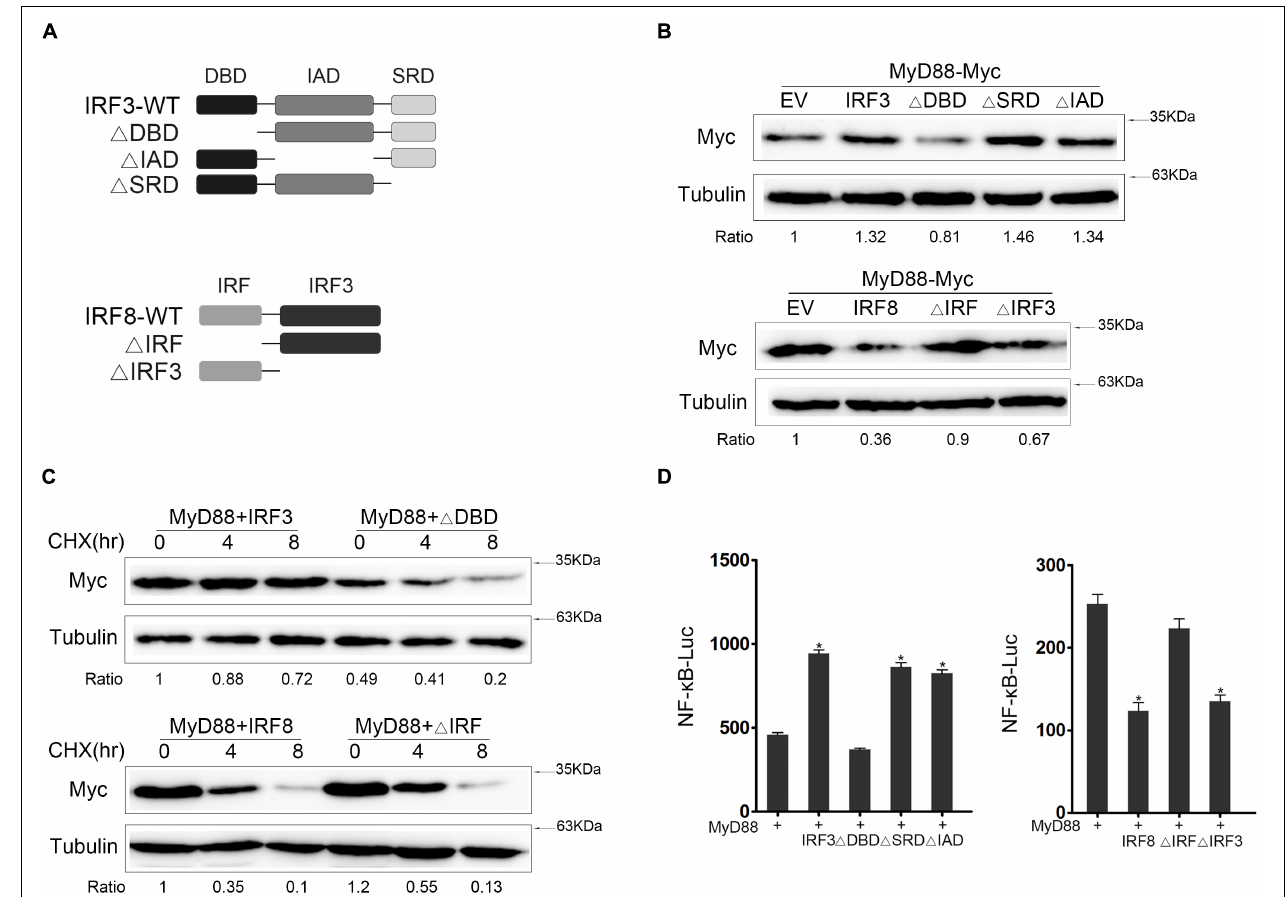
FIGURE 5 | The core regulatory domain of IRF3 and IRF8. (A) Schematic diagram of the wild type (WT) and mutants of IRF3 or IRF8. (B) Epithelioma papulosum cyprini (EPC) cells were seeded in 12-well plates and transfected with 0.4 µ g of IRF3 and IRF3 mutant plasmids with 0.4 µ g of MyD88. At 24 h post transfection, the immunoblot assays were measured. EPC cells were seeded in 12-well plates and transfected with 0.4 µ g of IRF8 plasmid and IRF8 mutant plasmids with 0.4 µ g of MyD88 plasmid. At 24 h post transfection, the immunoblot assays were measured. (C) HEK293 cells were seeded in 12-well plates and transfected 0.4 µ g of IRF3 and (cid:49) DBD plasmids or IRF8 and IRF8 (cid:49) IRF together with 0.4 µ g of MyD88. At 24 h post transfection, the cells were treated with CHX (100 µ g/ml) for different times, and then MyD88 was determined by immunoblot assays. (D) EPC cells were seeded in 24-well plates and cotransfected with 0.2 µ g of IRF3 and IRF3 mutant plasmids or IRF8 and IRF8 mutant plasmids, respectively, together with 0.2 µ g of MyD88 and 0.25 µ g of NF- κ B reporter gene, and the luciferase activity was measured. * p < 0.05 versus the controls. All experiments were performed in at least three independent